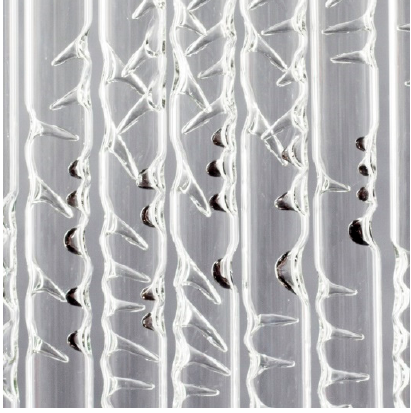
Figure 9. Detail of tubes with embedded textures and colours (2017) by Ayako Tani.